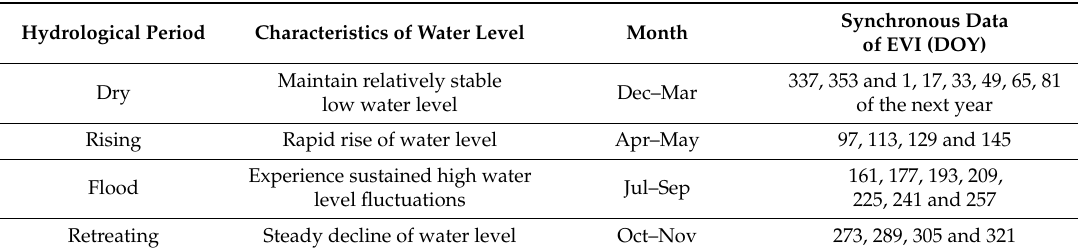
Table 2. Hydrological periods of Poyang Lake and the MODIS EVI time series with the same overpass time. DOY: day of